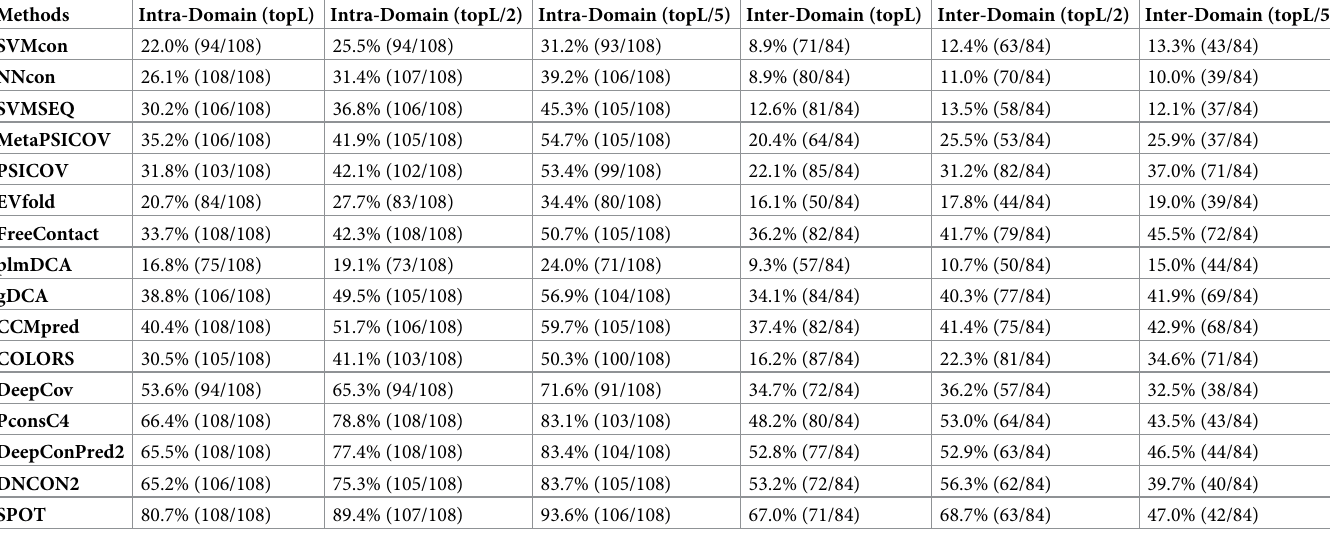
Table 2. Intra- and inter-domain prediction precisions of top L, L/2 and L/5 all-range predictions by 16 methods on TestSet1. Methods